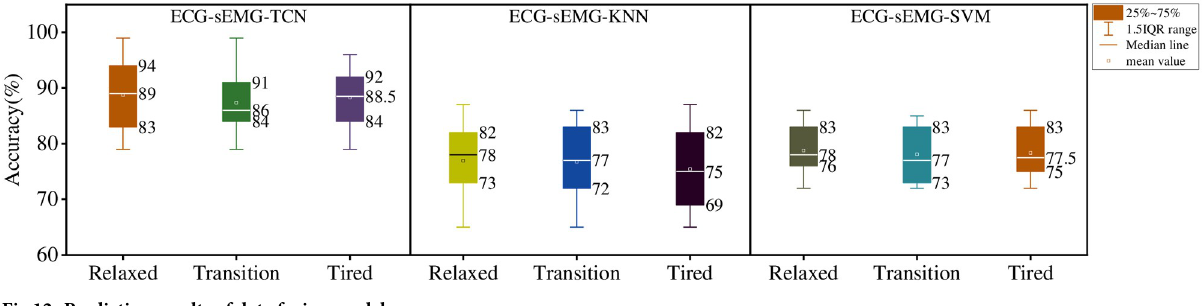
Fig 12. Prediction results of data fusion